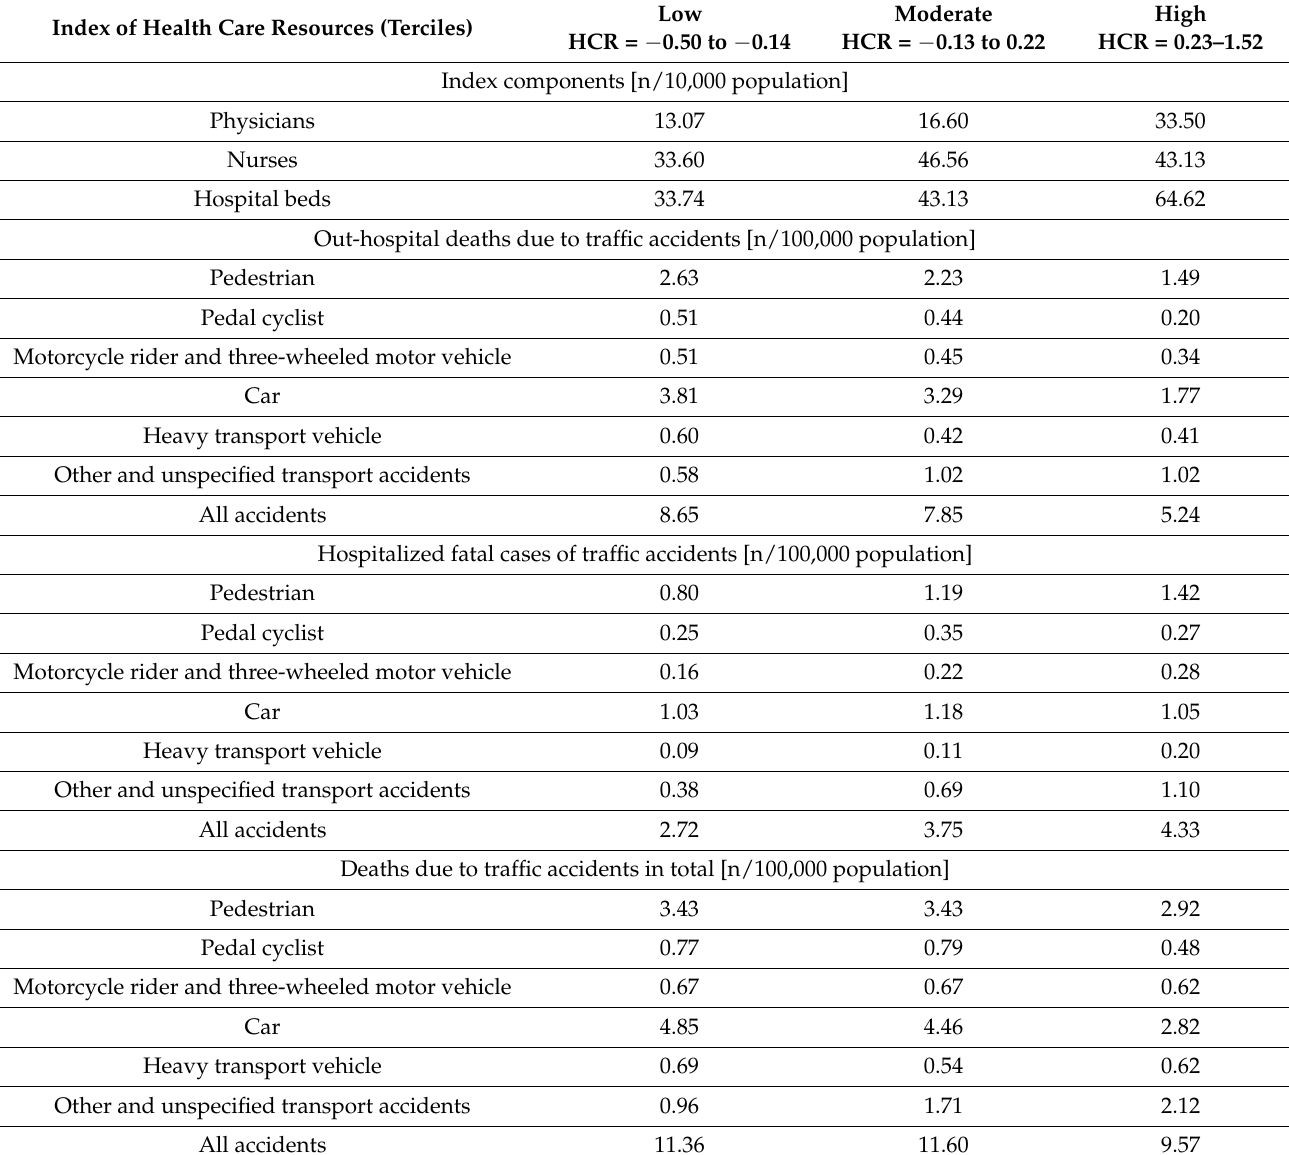
Table 1. Descriptive statistics for the health care and for deaths due to type of traffic accidents by health care resources (HCR) index in 66 sub-regions of Poland averaged over the period